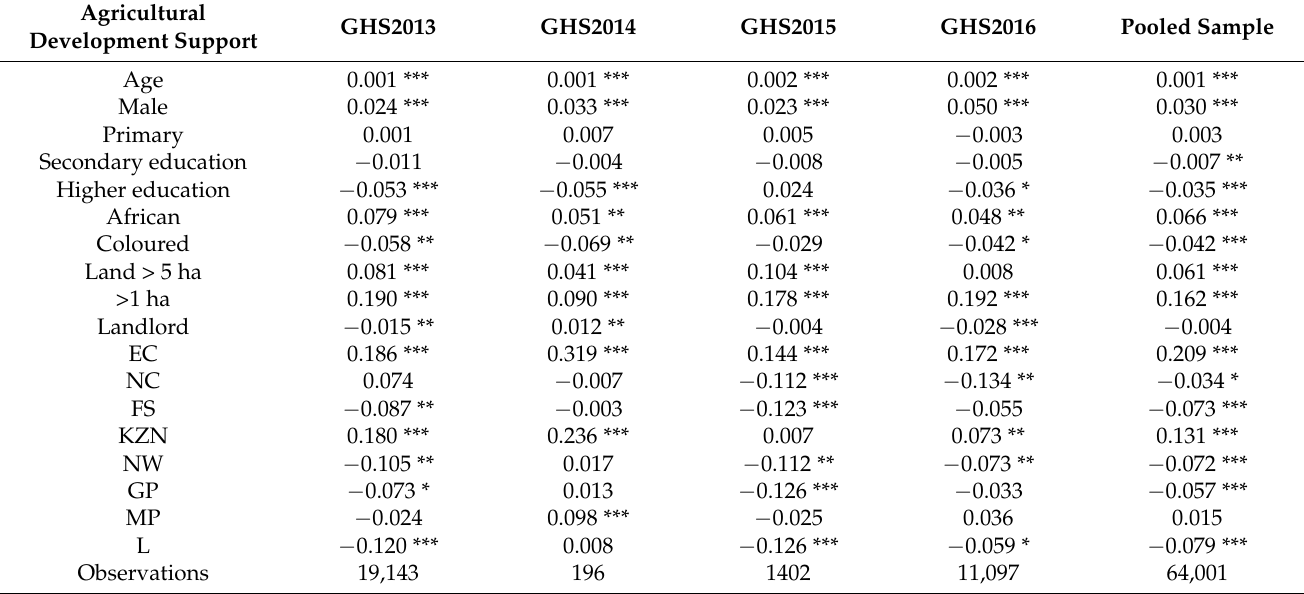
Table 2. Determinants of farmers’ access to agricultural development